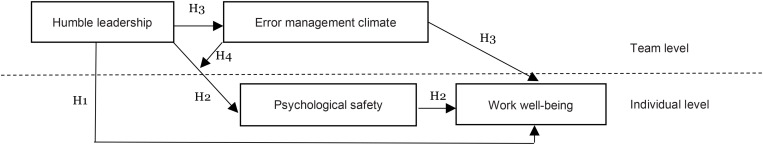
Theoretical model of the present study.